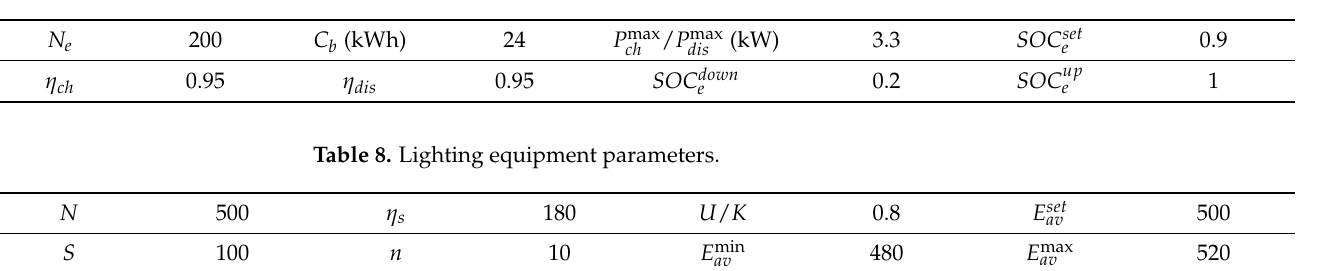
Table 7. Parameters of EV charging and discharging.